Question: Which visualization type does this figure use?
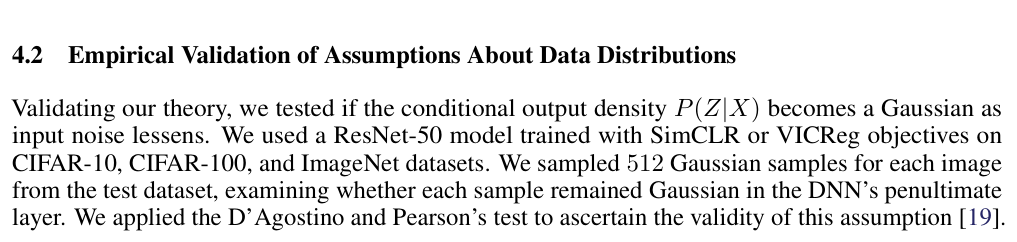
Answer: line